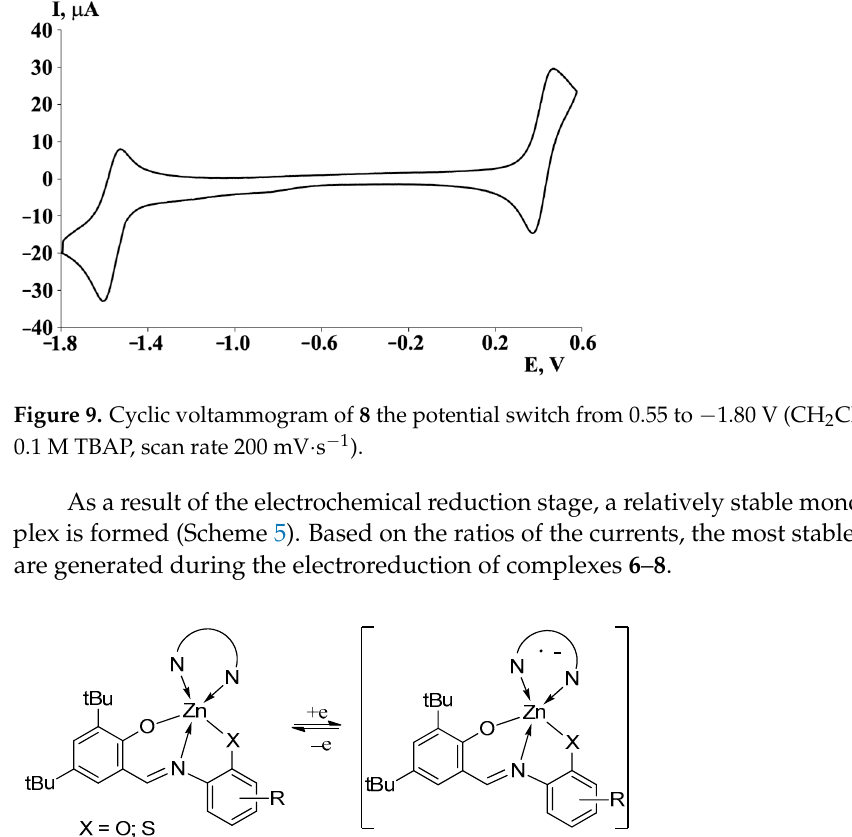
10 of 22 Figure 8. Cyclic voltammogram of 3 the potential switch from 0.50 to − 1.80 V (CH 2 Cl 2 , C = 2 mmol, 0.1 M TBAP, scan rate 200 mV ∙ s − 1 ). For compounds 1 and 2 , a weakly resolvable pre-peak at − 1.30 V is observed, which presumably corresponds to the reduction of the nitro group. For a free ligand, a similar redox process is also irreversible, but it is observed at a potential of − 0.70 V. Taking into account the presence of the dianionic form of the ligand in 1 and 2 and the expected shift of reduction potentials to the cathodic region, it can be assumed that the nitro group is involved in this electrode process. The additional cathode peaks observed in the range of − 1.40 to − 1.50 V are in good agreement with the previously obtained results for zinc com- plexes with coordinated bipyridyl or phenanthroline and an additional S-donor ligand